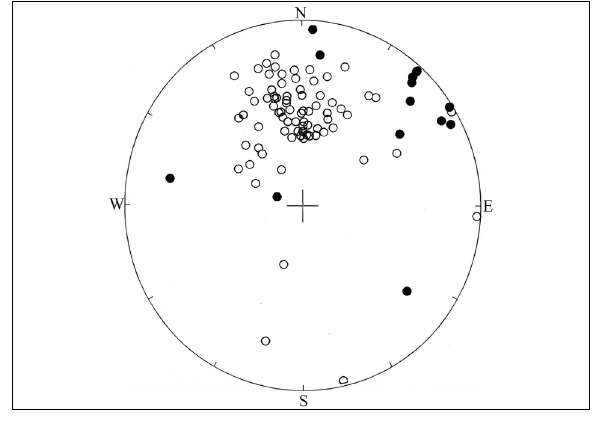
Figure 5: Directional data with field correction of characteristic remanent magnetisations of each sample for the section reported in this paper. Negative inclination (open circle) and positive inclination (solid circle). (Figure 7).